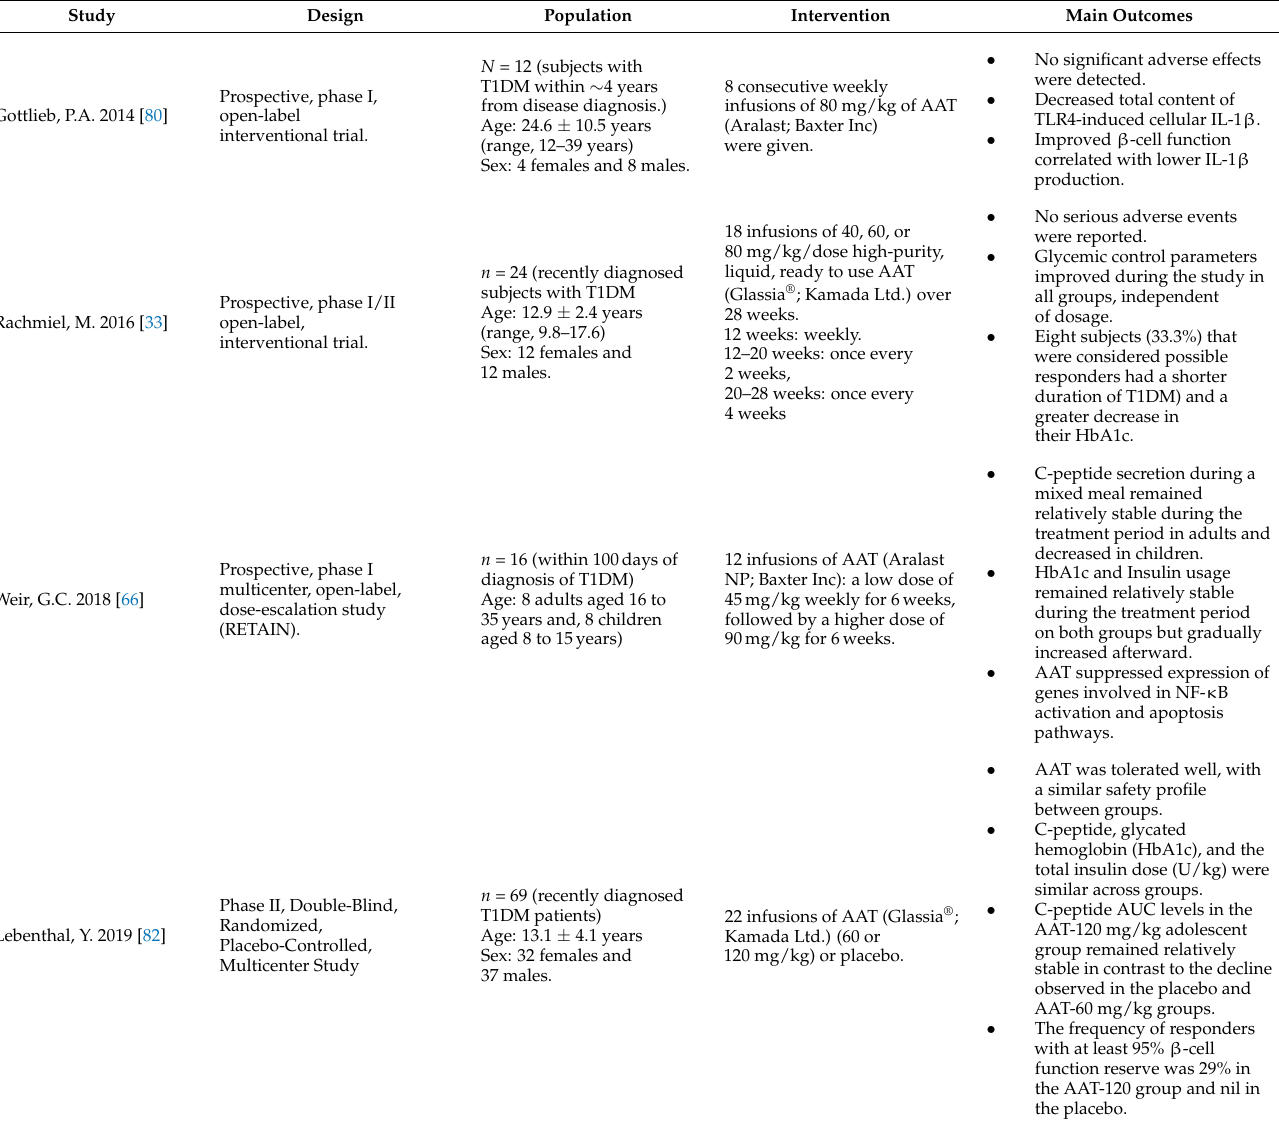
Table 1. Summary of clinical trials of Alpha-1 Antitrypsin in type 1 diabetes